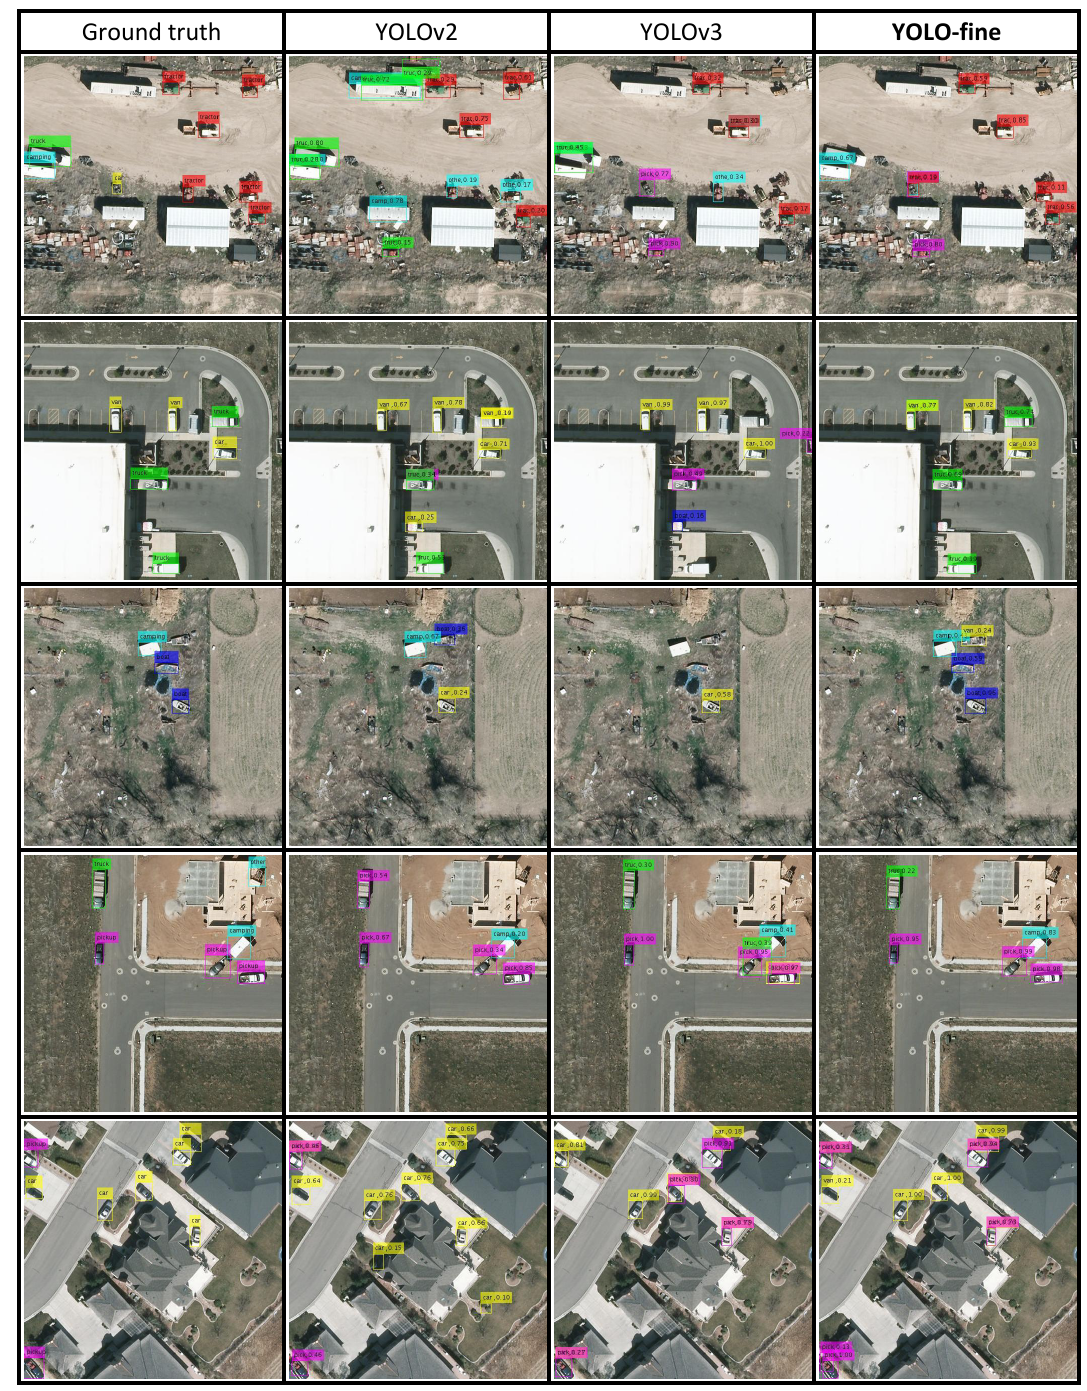
Figure 7. Illustration of detection results on VEDAI1024 (color